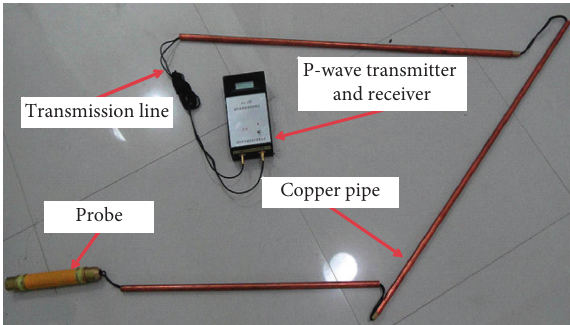
Figure 5: BA-II ultrasonic rock fracture detector.